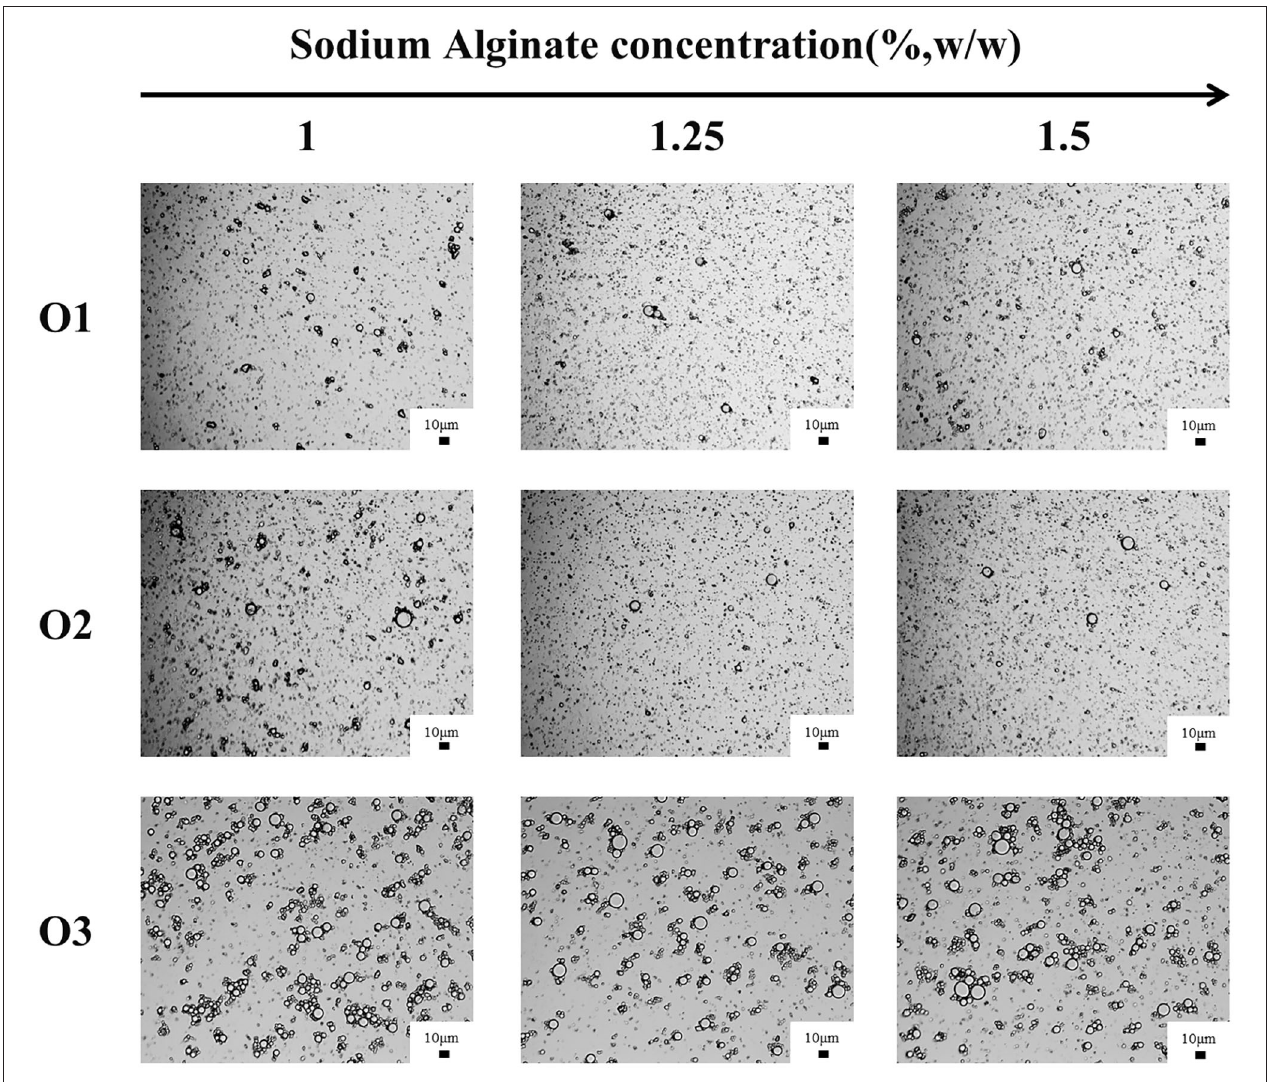
FIGURE 7 | Optical microstructure images of O1, O2, and O3 emulsions stored for 28 days (scale bar is 10 µ